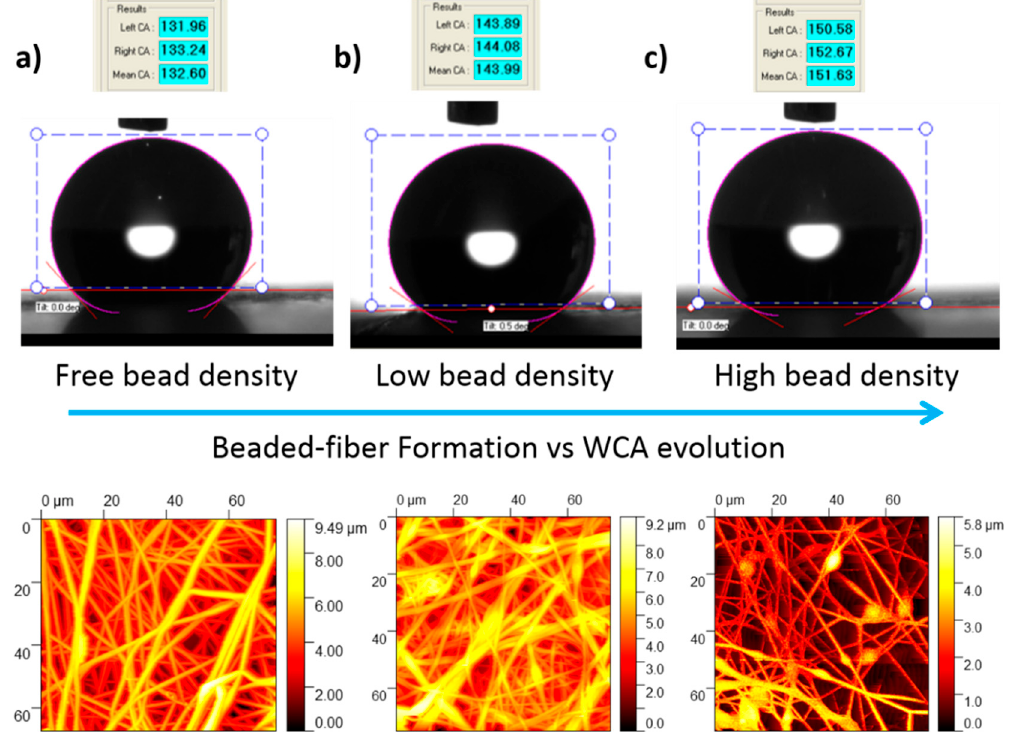
Figure 5. Comparison between the water contact angle images recorded for the PVC electrospun fiber mats with their corresponding AFM images for Sample 4 with free bead density ( a ), Sample 2 with low bead density ( b ), and Sample 5 with high bead density ( c ), respectively.